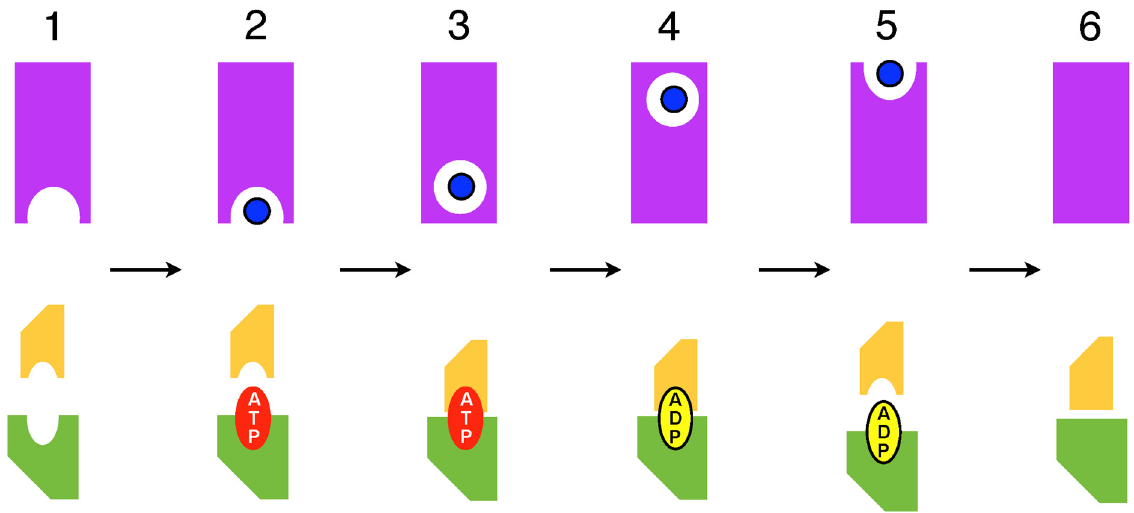
Figure 3. Coupling between the ATP hydrolysis and substrate translocation cycles in the Reciprocating Model. Scheme for an ABC exporter is shown. The cycle of ATP binding, occlusion, and hydrolysis, followed by NBS opening and product release in one NBS is directly coupled to an analogous cycle of substrate binding, occlusion, translocation, and presentation at the extracellular side and release in one of two functionally separate substrate translocation pathways. Top Panel: A single TM translocation channel (TMC) is depicted as a magenta rectangle with the substrate ‐ binding site as an inward ‐ or outward ‐ facing semicircle. The occluded substrate ‐ binding site is depicted as a circle within the TMC and the substrate as a blue dot. Bottom Panel: One composite active site (NBS) is depicted by two shapes representing the helical domain of one NBD (smaller, yellow) and the RecA ‐ like domain of the opposite NBD (larger, green). The numbered steps that define the cycle are: ( 1 ) High affinity inward ‐ facing substrate binding site is empty and NBS active site is open and empty. ( 2 ) Substrate binds to the inward ‐ facing site and ATP binds to NBS. ( 3 ) Substrate is sequestered in an occluded site on the cytoplasmic side of the membrane; ATP is occluded in the active site. ( 4 ) ATP is hydrolyzed, coupled with substrate translocation to an occluded site at the extracellular side of the membrane. ( 5 ) Opening of ADP ‐ bound active site corresponds to the substrate bound to extracellular ‐ facing low affinity site. ( 6 ) Substrate and ADP nucleotide disengage; NBS and TMC are in a low affinity states.